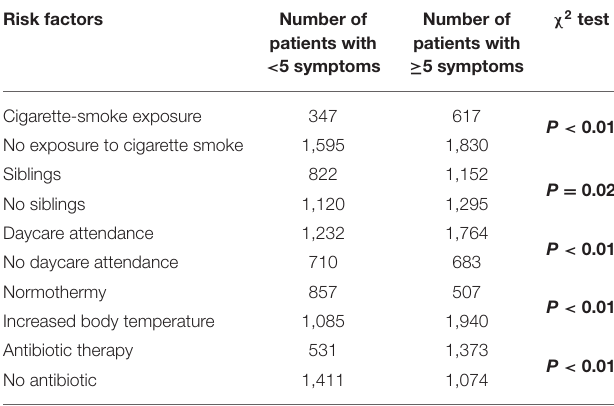
TABLE 1 | The presence of at least five symptoms of URTIs and selected environmental and clinical factors in the study group ( n = 4,389). Risk